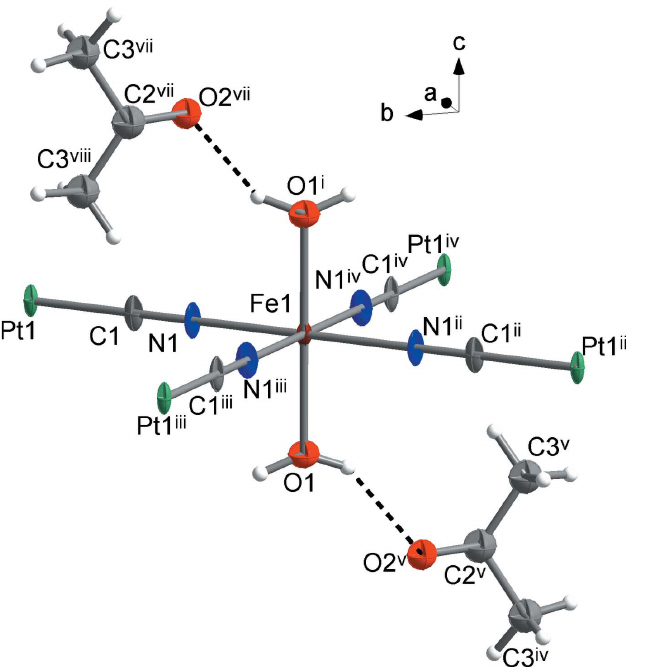
Figure 1 A fragment of the molecular structure of the title compound showing the atom-labelling scheme. Displacement ellipsoids are drawn at the 50% probability level [symmetry codes: (i) x , (cid:3) y , 1 (cid:3) z ; (ii) (cid:3) x , (cid:3) y , z ; (iii) x , (cid:3) y , z ; (iv) (cid:3) x , y , z ; (v) (cid:3) 1 + x , (cid:3) y , z ; (vi) (cid:3) 1 + x , (cid:3) y , (cid:3) z ; (vii) 1 (cid:3) x , y , 1 + z ; (viii) 1 (cid:3) x , y , 1 (cid:3) z ].